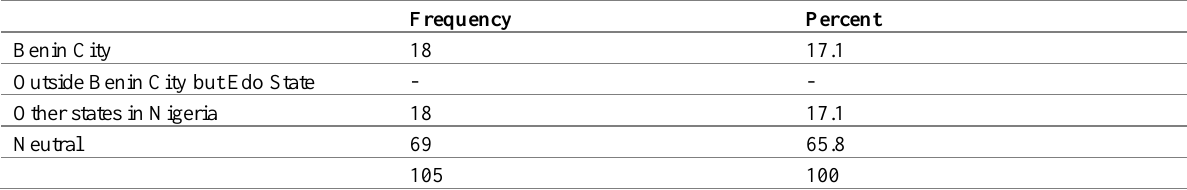
Table 4: Do you transfer technical skills/technology to businesses in any of the following location Frequency